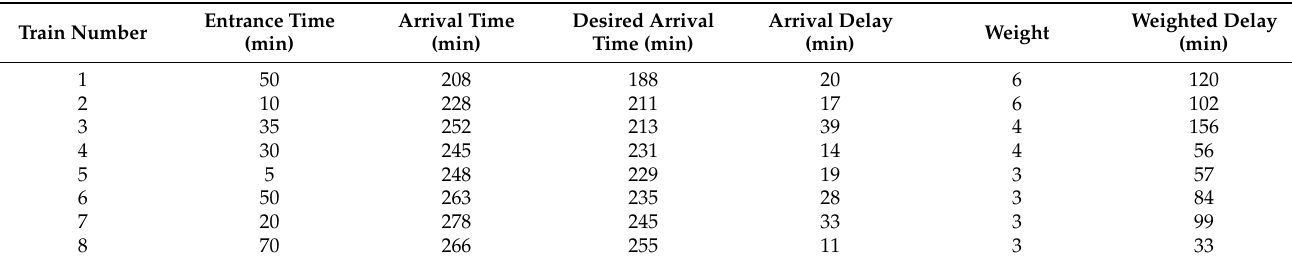
Table 18. Summary of the optimal solution of the 4 + 4 instance.